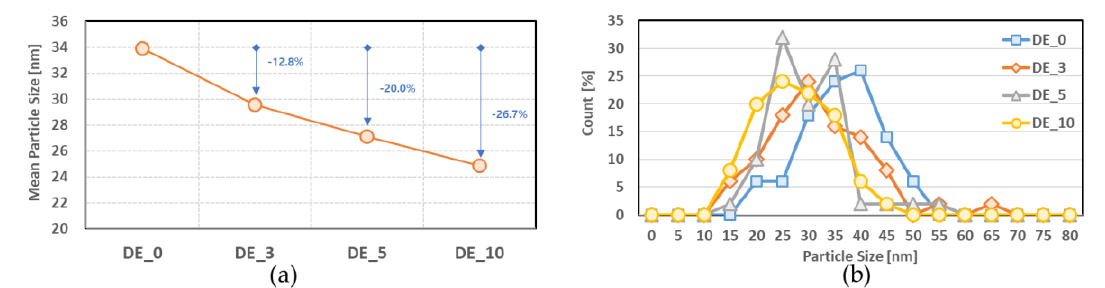
Figure 9. Images of TEM ( a ) DE_0, ( b ) DE_3, ( c ) DE_5, ( d ) DE_10.